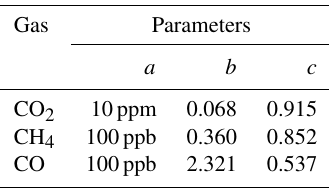
Table 8. Parameters for the model of posterior error in terms of signal-to-noise